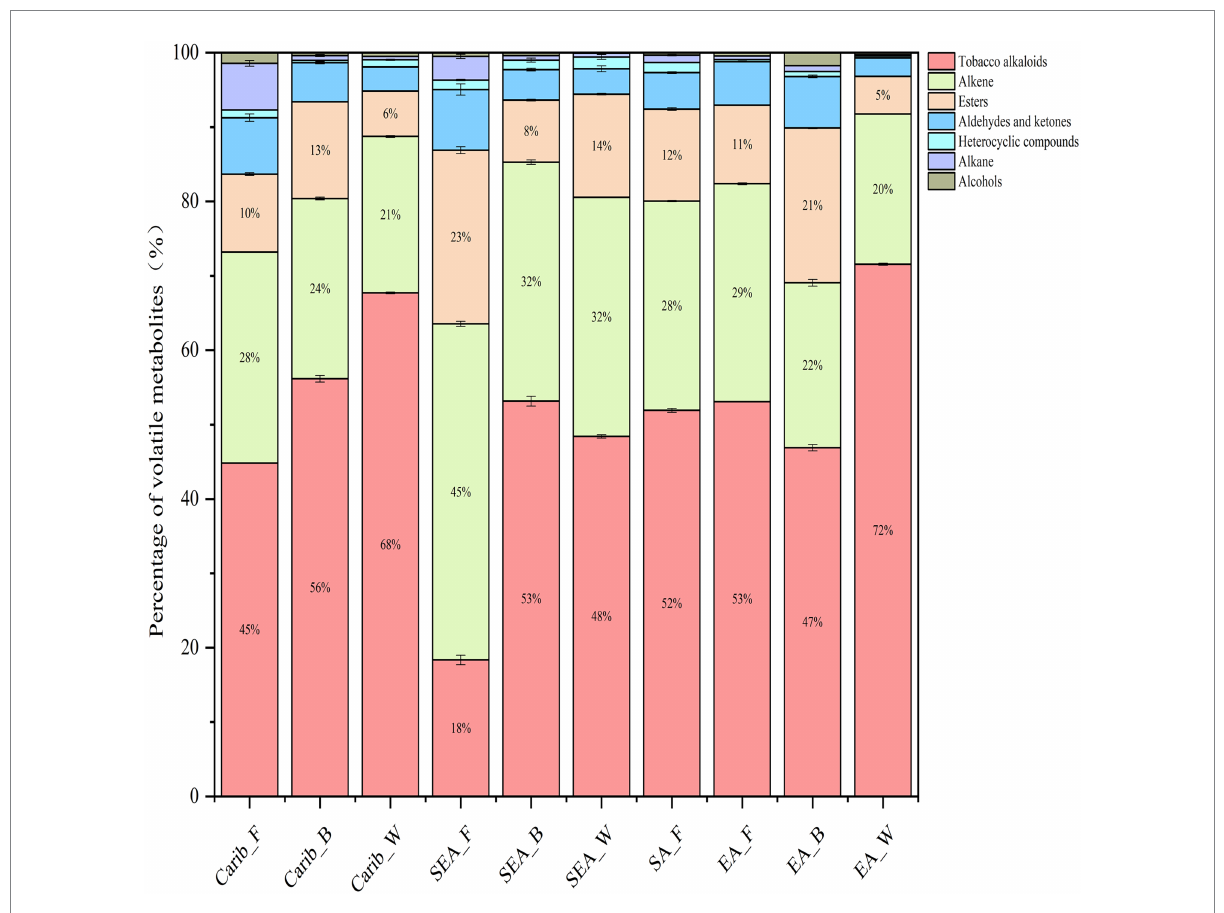
FIGURE 7 Composition of volatile metabolites of cigars from different